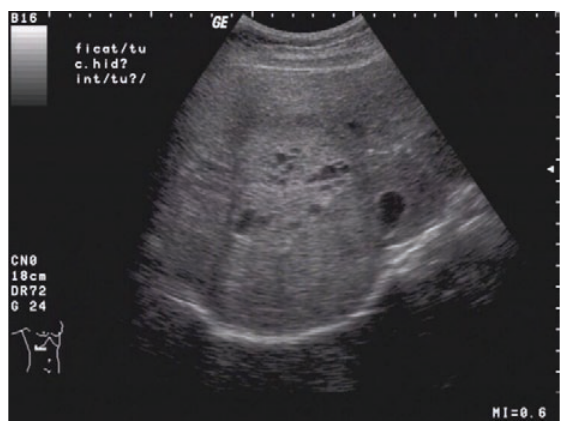
Figure 1. Microscopic aspect of a neuroendocrine tumor. Figure 2. Liver metastasis of ileal neuroendocrine